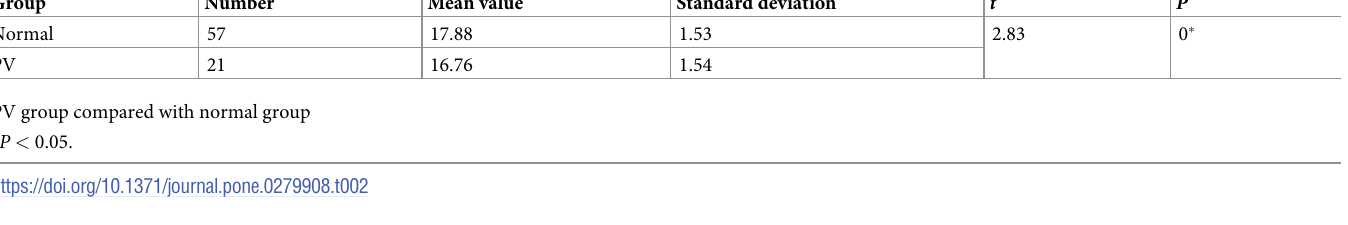
Table 2. ELISA method to detect the protein level of GSDMB in skin tissue (ng/mL). Group